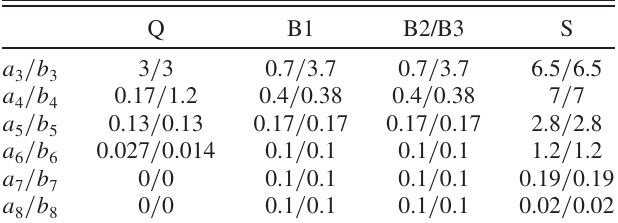
TABLE VI. Random higher-order multipole errors in units of 10 − 4 (primary coils).